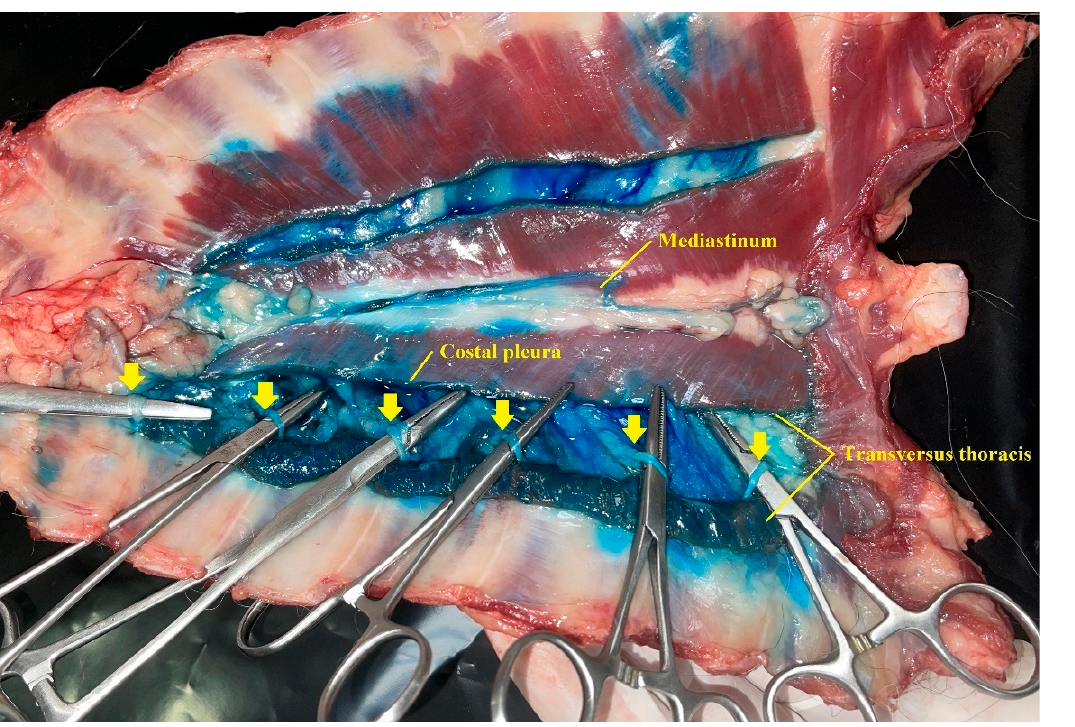
Figure 4. Image of the transversus thoracis plane after performing the blockade and the anatomical dissection. Costal pleura and TT muscle were sectioned along the longitudinal axis of the TT muscle,